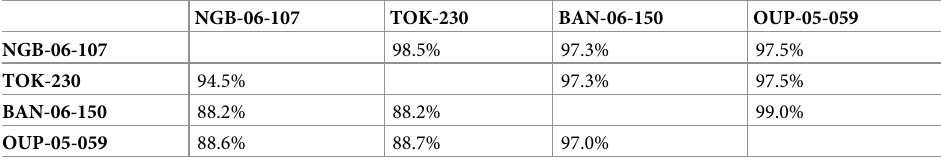
Table 1. Pairwise identity between the genomes of the studied EV-D111 isolates (lower left) and between the deduced polyprotein (upper